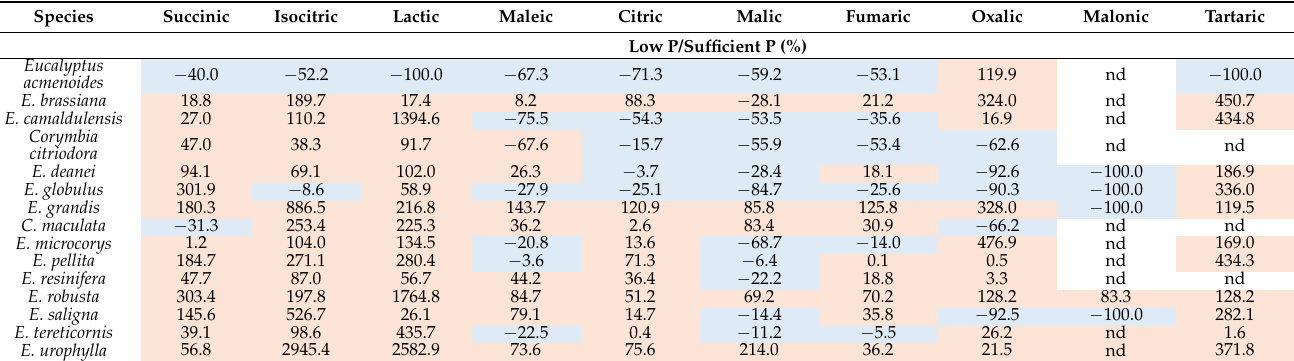
Table 1. Percentage of change between the amount of individual organic acids exuded by roots under low and sufficient phosphorus concentrations in each eucalypt species. Blue-shaded cells indicate a decrease and orange-shaded cells indicate an increase in the percentage of change. nd = not found in the species.